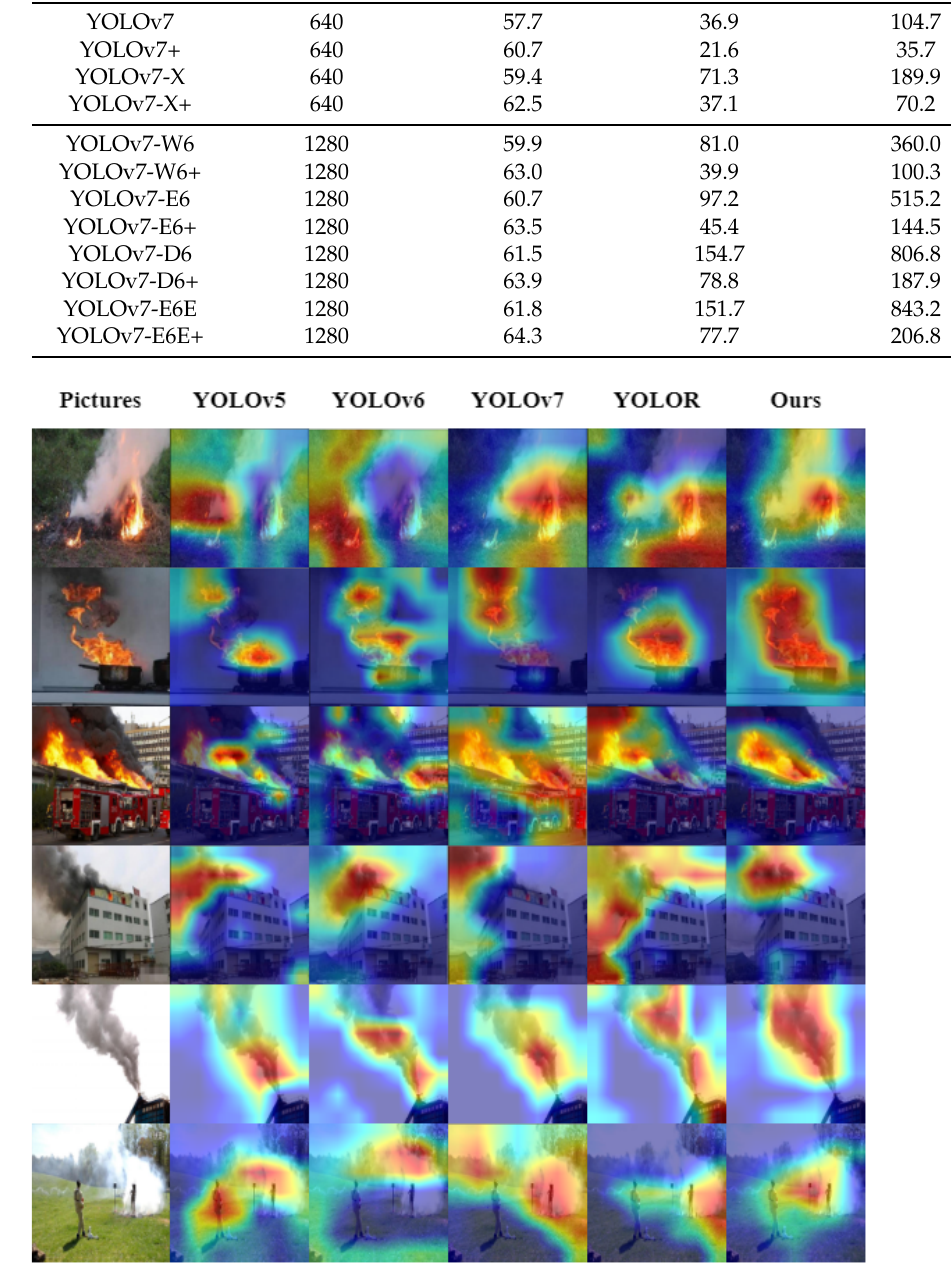
Figure 9. Comparison of heatmaps results with one-stage object detectors. The deeper the colour of the area the stronger the